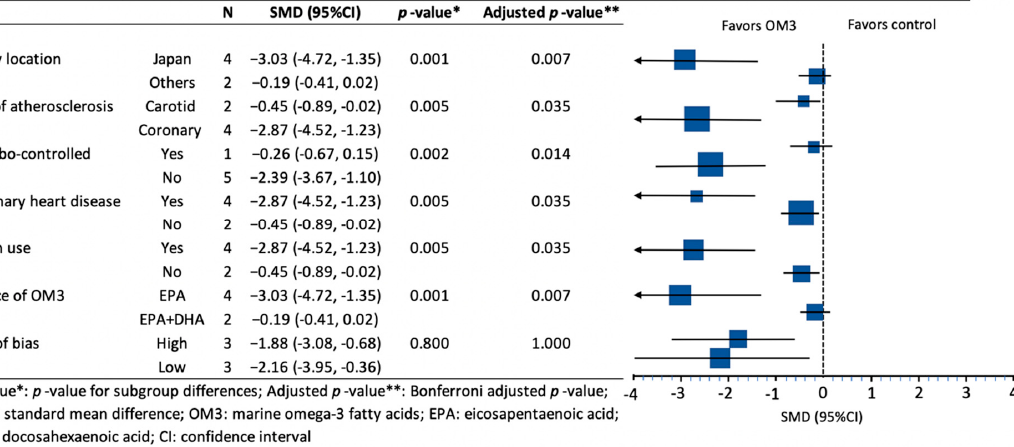
Figure 4. Subgroup analysis of the meta-analysis.